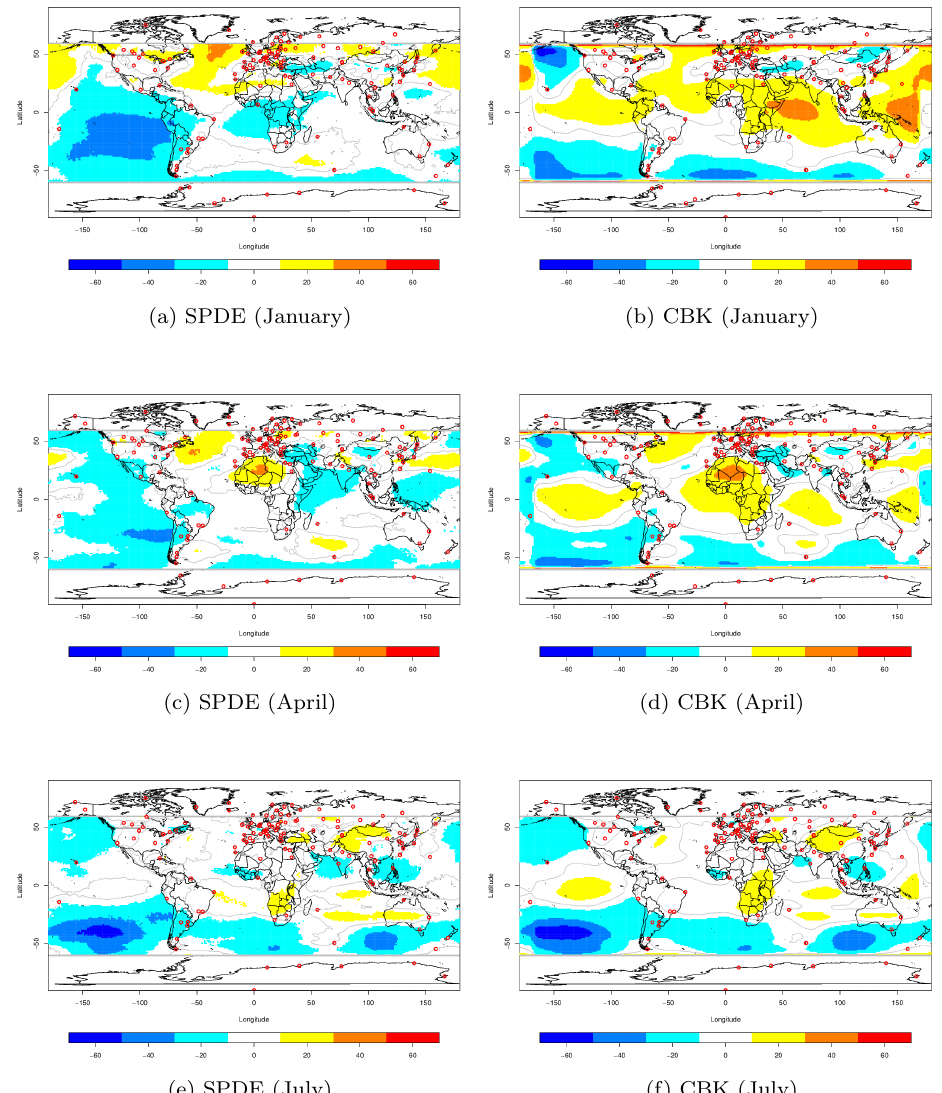
Figure 4. Total ozone (DU) difference mapping of SPDE and covariance-based kriging (CBK) estimated mean with respect to satellite data from January, April and July 2000.